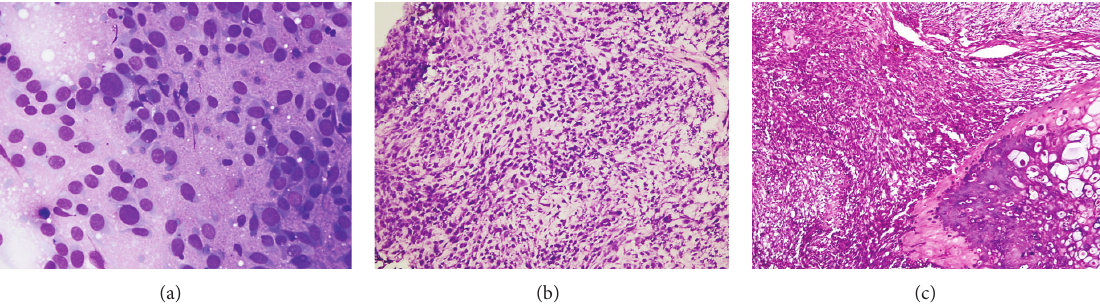
Figure 2: (a–c) Chondrosarcoma: (a) hypercellular smear showing singly scattered tumor cells having moderate pleomorphism and unipolar or bipolar cytoplasmic tags; an atypical mitotic figure is also present (MGG stain, × 400); (b) fascicles of tumor cells having moderate anaplasia which are noted in frozen section (H&E, × 200); (c) paraffin-embedded section displaying a tumor arranged in short fascicles with anaplastic spindle shaped cells. Right lower corner shows malignant chondroid differentiation (H&E, ×